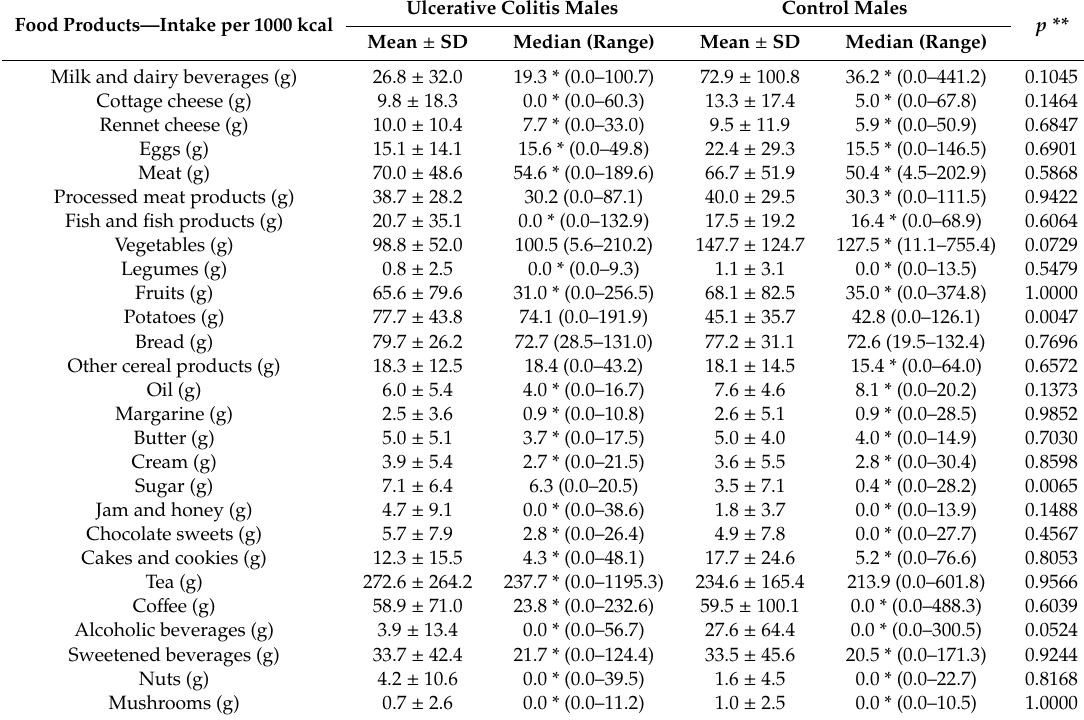
Table 8. The food products intake per 1000 kcal in ulcerative colitis males and control